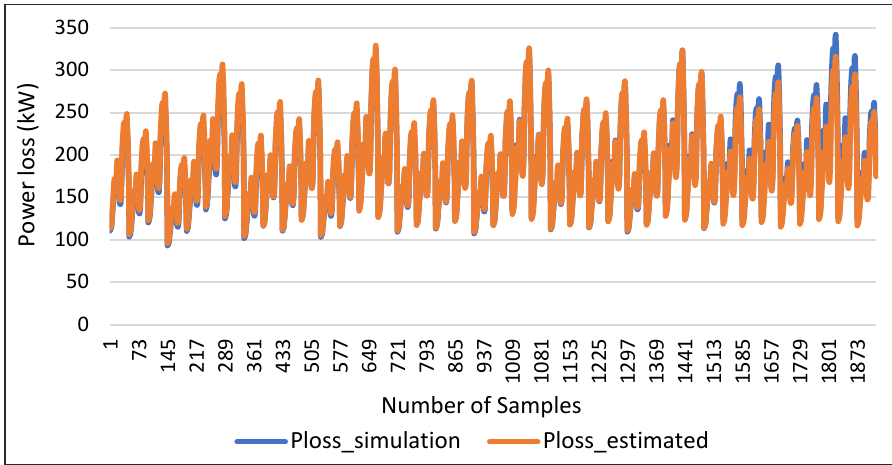
Figure 9. Active power loss obtained for case 1 for function 2.